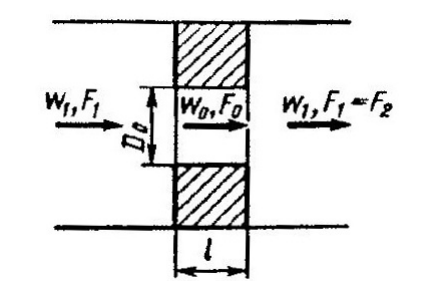
Figure 3: Orifice in a straight tube to evaluated the K